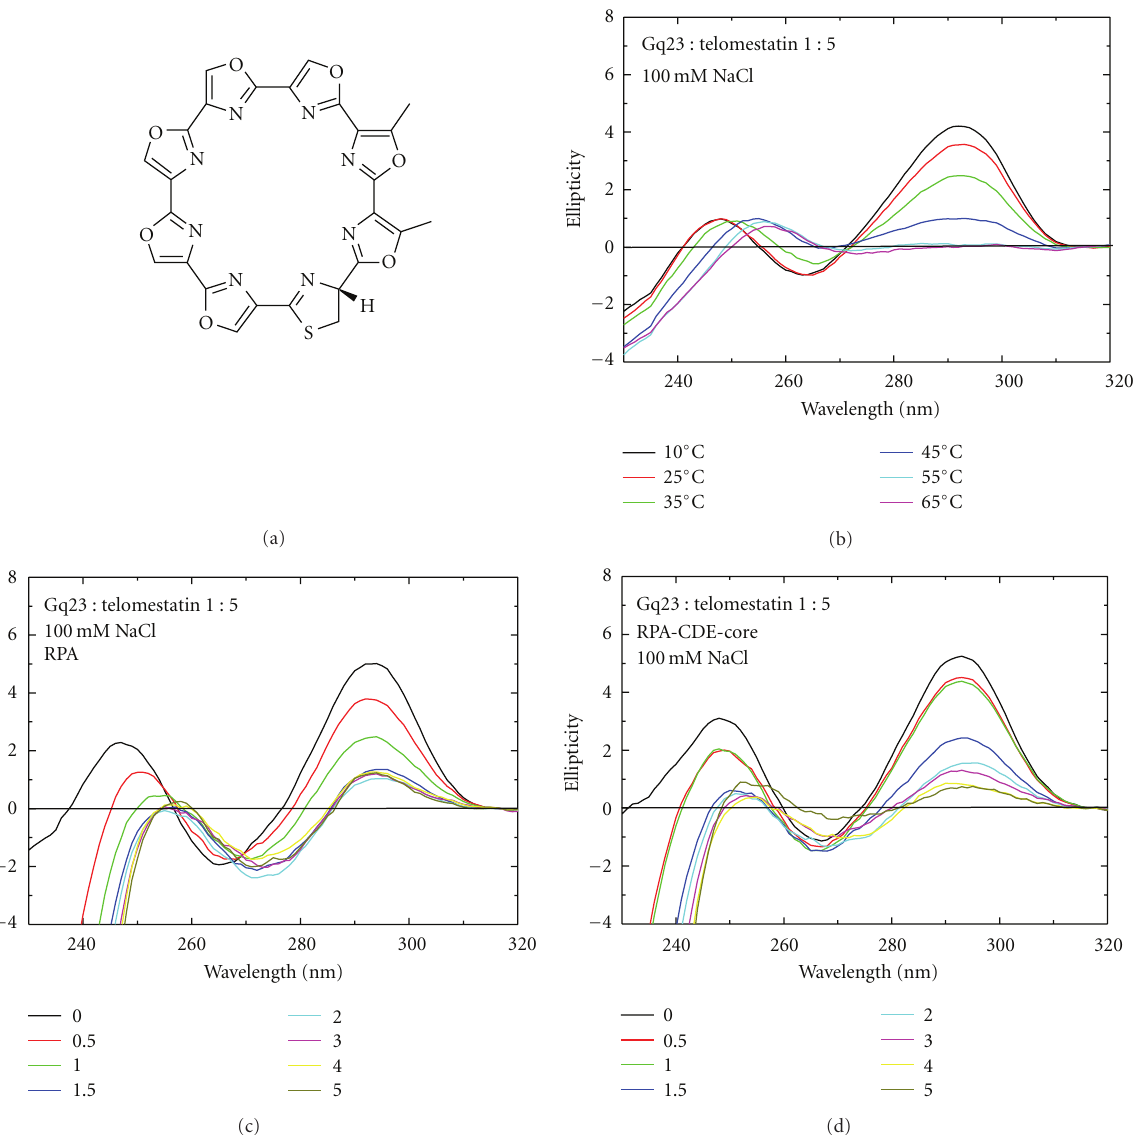
Figure 8: E ff ects of telomestatin and RPA on Gq23 in the presence of Na + ions. (a) Chemical structure of telomestatin. (b) CD spectra of Gq23 at varying temperatures in the presence of a 1 :5 molar ratio of Gq23: telomestatin. (d) Spectra of increasing molar ratios of RPA (0–5) added to above Gq23 :telomestatin complex and (d) spectra of increasing molar ratios of RPA-CDE-core added to the Gq23 : telomestatin complex. All spectra were recorded in